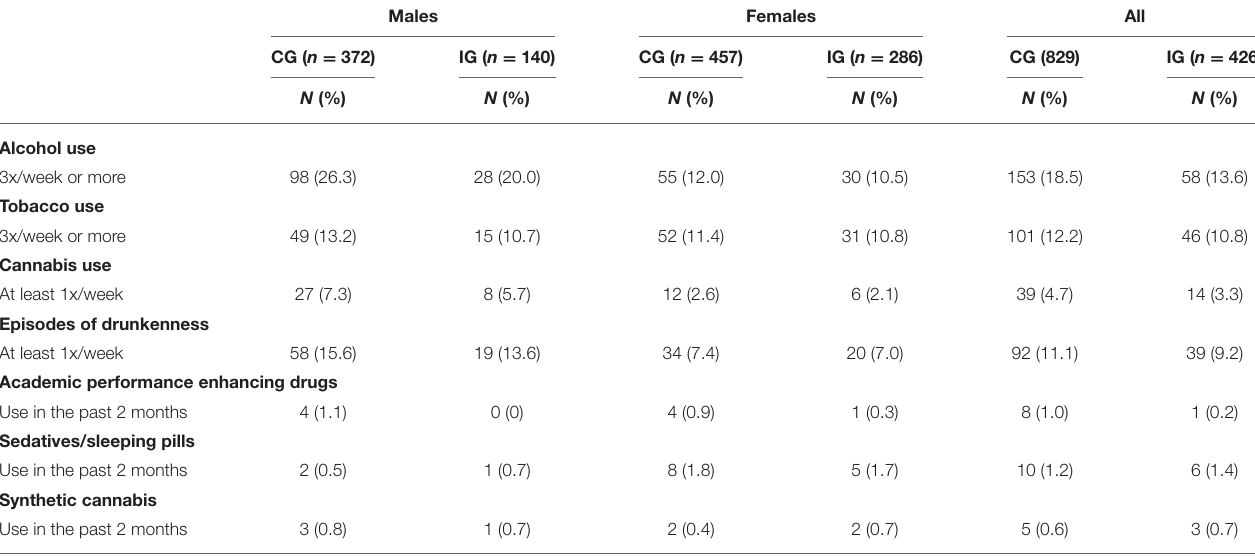
TABLE 2 | Baseline prevalence of licit and illicit substance use by group and gender.